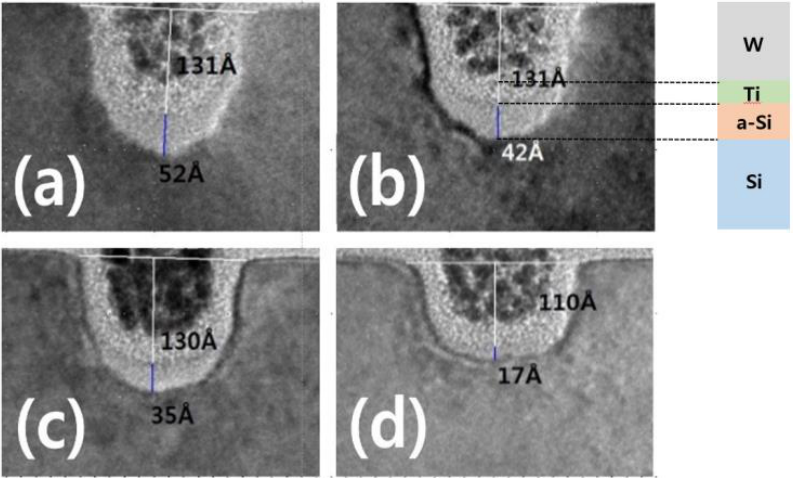
Figure 2. TEM images of the Si contacts with application of the soft treatment process for ( a ) 0 s, ( b ) 10 s, and ( c ) 20 s. ( d ) is for 30% reduced etching power. Different sizes of the contact chain structures fabricated in the test element group (TEG) were used to define the RC characteristics. The electrical tests, including R C , I-V, and HEIP, were conducted using an Agilent HP4072 system